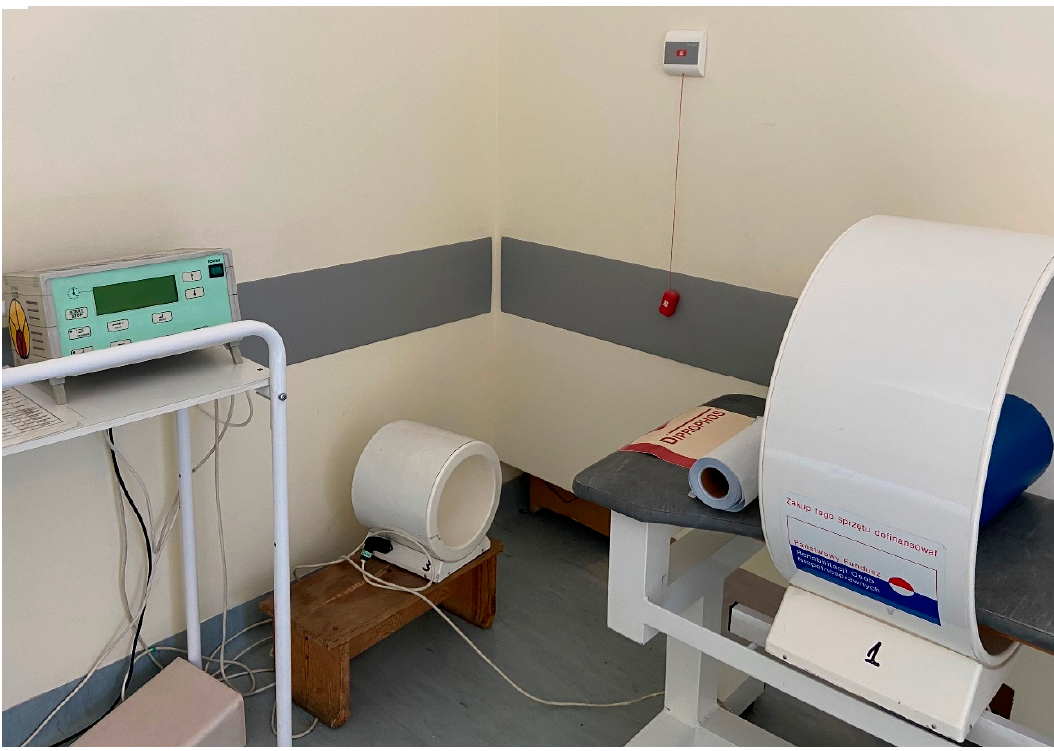
Figure 1. Device to generate extremely low frequency electromagnetic field (ELF-EMF)—Magnetronic MF10 (EiE Elektronika i Elektromedycyna, Otwock, Poland).